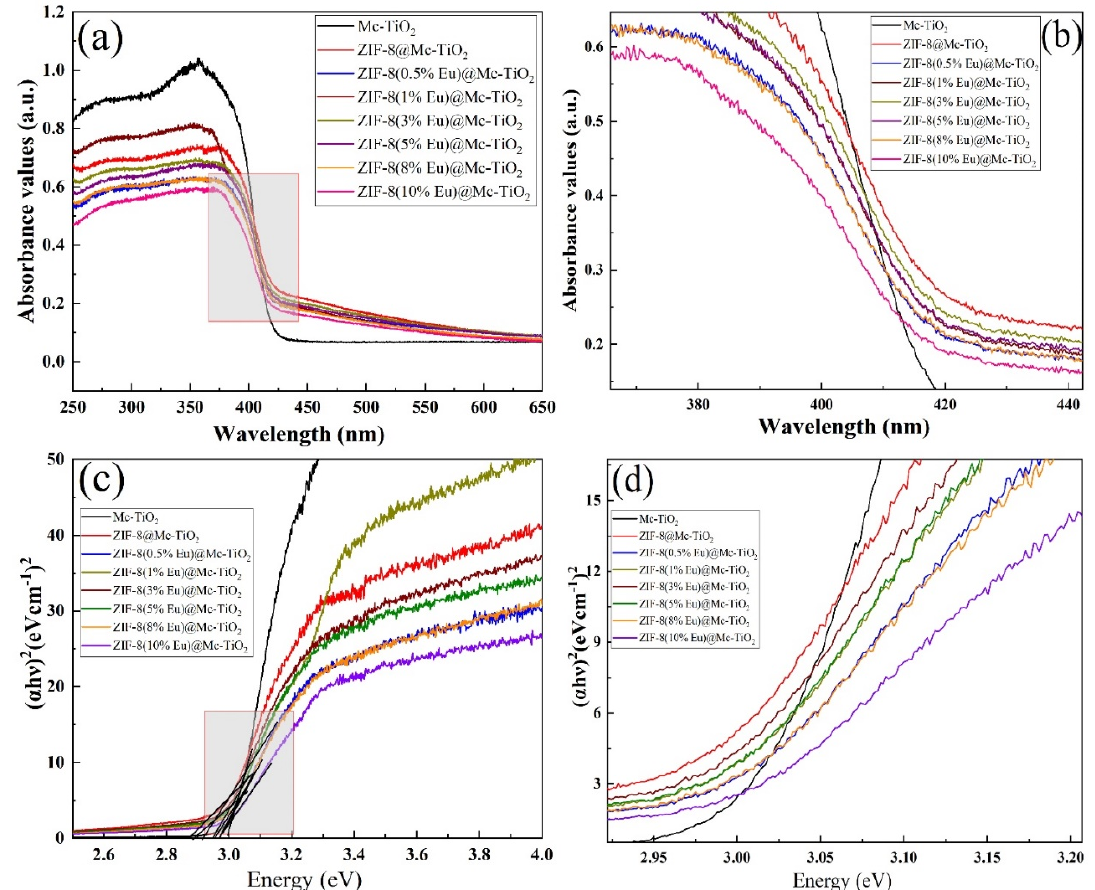
Figure 6. UV-Vis DRS diagram ( a , b ) and band gap width diagram ( c , d ).